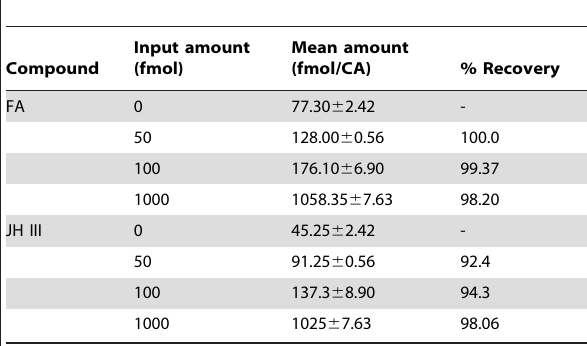
Table 2. Recovery of labeled FA and